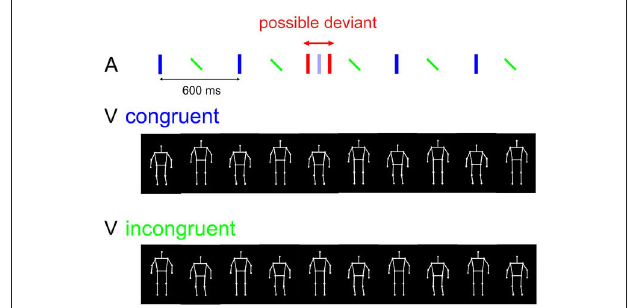
FIGURE 1 | Stimuli and trial procedure of the experiment. In each trial, an auditory beat sequence (upper panel) consisted of five alternating downbeats (blue vertical bars) and upbeats (tilted green bars), where accents were perceived in the former. The beat sequence was combined with either a congruently moving PLF (middle panel; moving down to the downbeat) or an incongruently moving PLF (lowest panel; moving up to the downbeat). Red bars depict a potential auditory deviant, which could be a delayed or advanced downbeat relative to its original temporal position (shown in opaque blue). The manipulation of synchrony between the auditory and visual streams is not illustrated here.